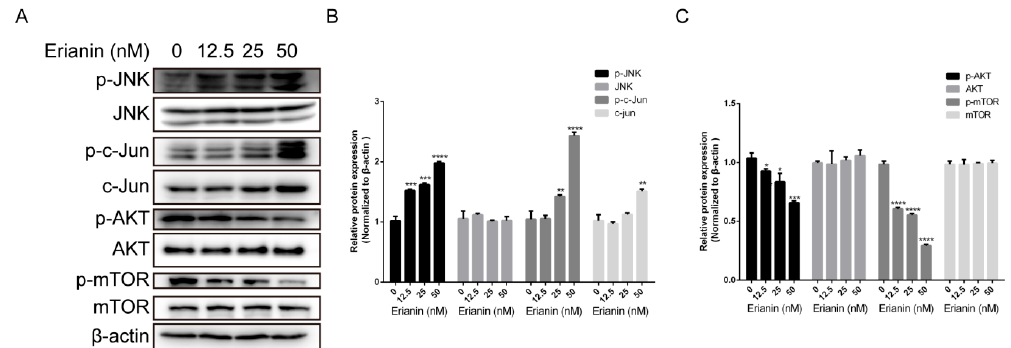
Figure 4. Erianin-activated JNK/c-Jun signaling pathway and erianin-inactivated AKT/mTOR signaling pathway in HaCaT cells. Cells were treated with various concentrations of erianin (12.5 nM, 25 nM and 50 nM) for 24 h. ( A ) Western blots for JNK/c-Jun and AKT/mTOR signal pathway. ( B ), ( C ) The relative expression intensity of each protein was normalized to the internal control β -actin. The values are expressed as mean ± SD ( n = 3). * p < 0.05, ** p < 0.01, *** p < 0.005, **** p < 0.001, significantly di ff erent compared with the untreated